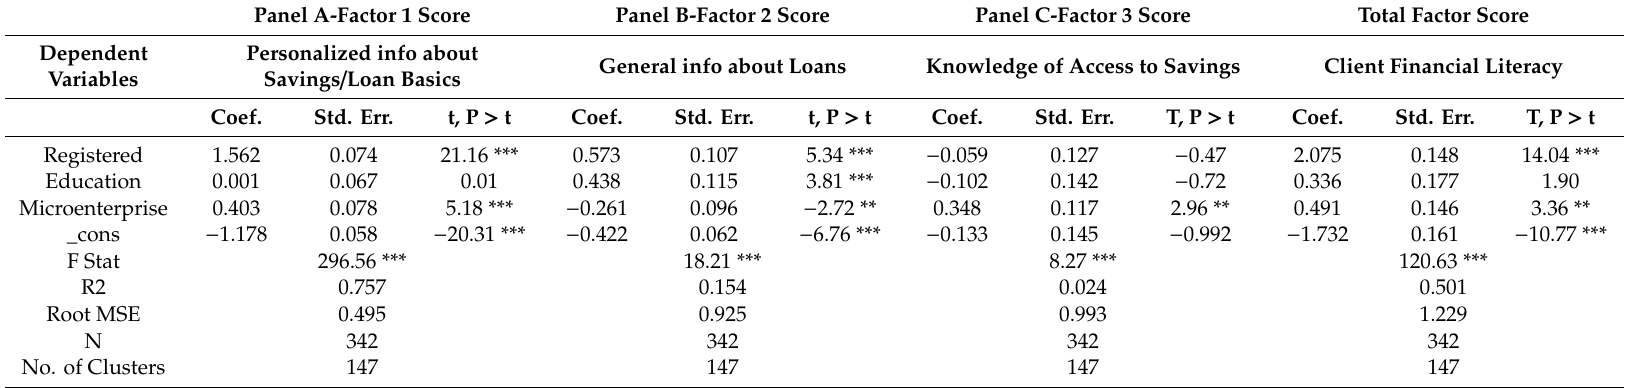
Table 6. Ordinary least squares (OLS) regression with dependent variable client financial literacy factors (Hypothesis